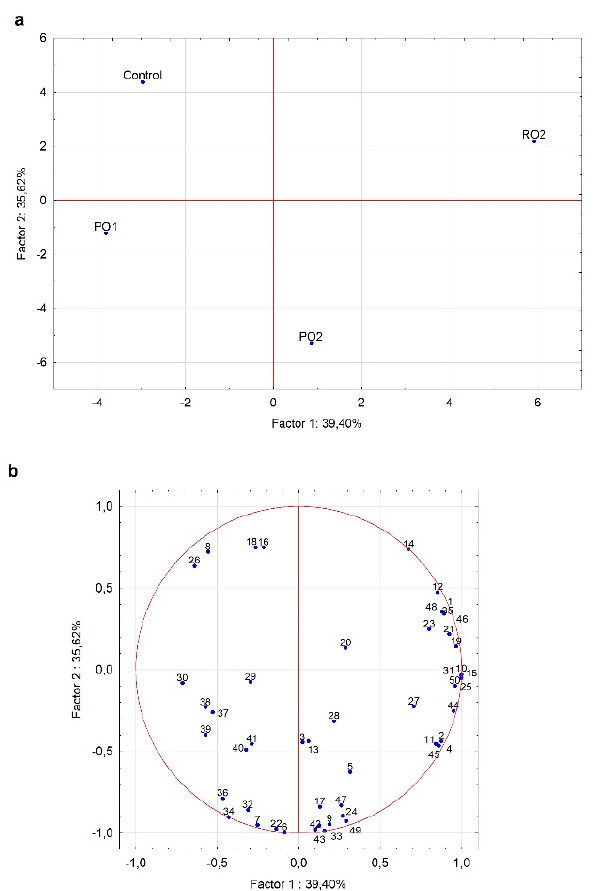
Figure 6. Projection on the factor plane (1 × 2) of squacquerone whey inoculated with three different strains of Y. lipolytica (RO2, PO1, PO2) and incubated for 72 h. The control was represented by caciotta whey without Y. lipolytica . ( a ) Treatments; ( b ) Variables. 1: butanoic acid, ethyl ester; 2: hex- anoic acid, ethyl ester; 3: oxalic acid, 6 − ethyloct − 3yl − ethyl ester; 4: propanoic acid, 2 − methyl ester;